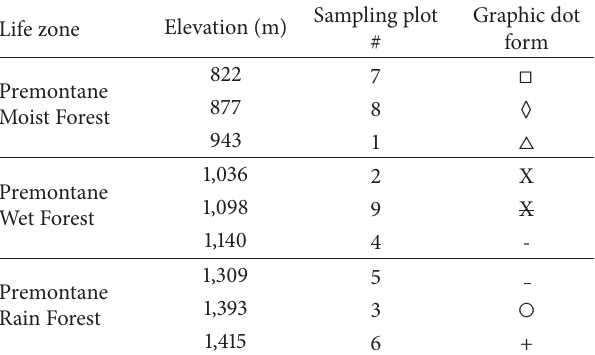
Table 1: Life zone, elevation, and graphic dot for each sampling plot. Sampling Life zone Elevation (m)